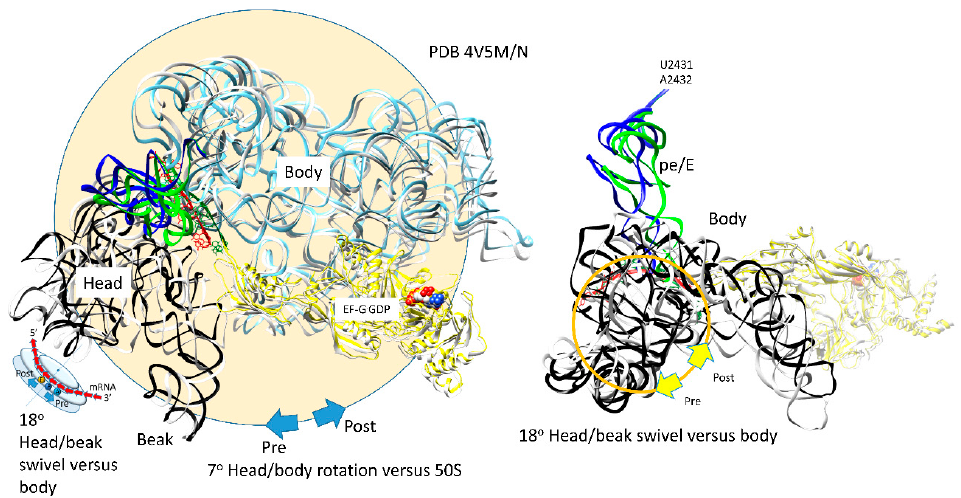
Figure 10. Two thermal rotary motions of the 30S subunit support forward translocation. The 30S subunit reversibly rotates ~7° versus the 50S subunit. The mRNA [red (post translocated) and green (pre-translocated)] threads between the 16S rRNA head/beak domain and the body (the neck), ~18° swiveling of the head/beak domain versus the body drives the mRNA forward and the mRNA:tRNA codon:anticodon attachments into hybrid states. For the pre-translocated state, mRNA and pe/E tRNA are green. 16S rRNA (pre) is white. For the post-translocated state, EF-G · GDP (extended conformation), mRNA, and pe/E site tRNA are yellow, red, and blue. The 16S rRNA (post) is light blue (body) or black (16S head/beak; 930–1380). In the rightmost image, the 16S rRNA body is not shown to simplify the image.